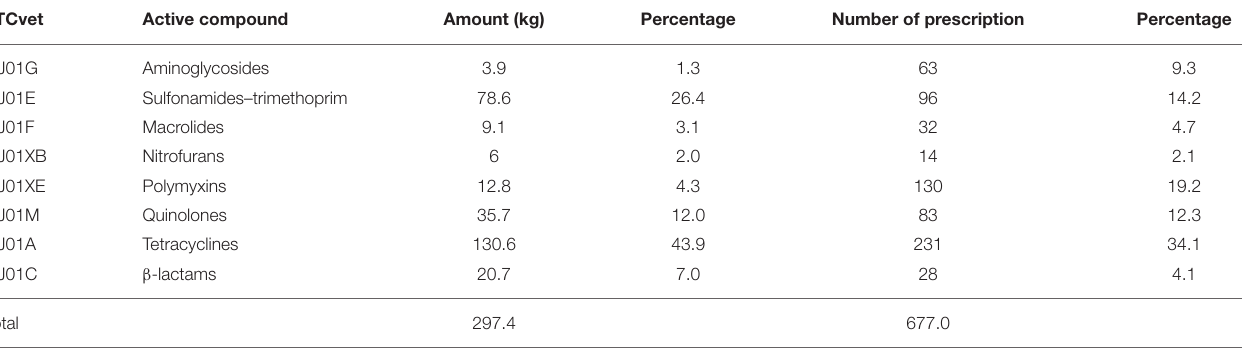
TABLE 3 | Consumption of antimicrobials (in amount) and the number of prescriptions from 50 layer poultry farms in the West Region in Cameroon from January 2012 to December 2012.